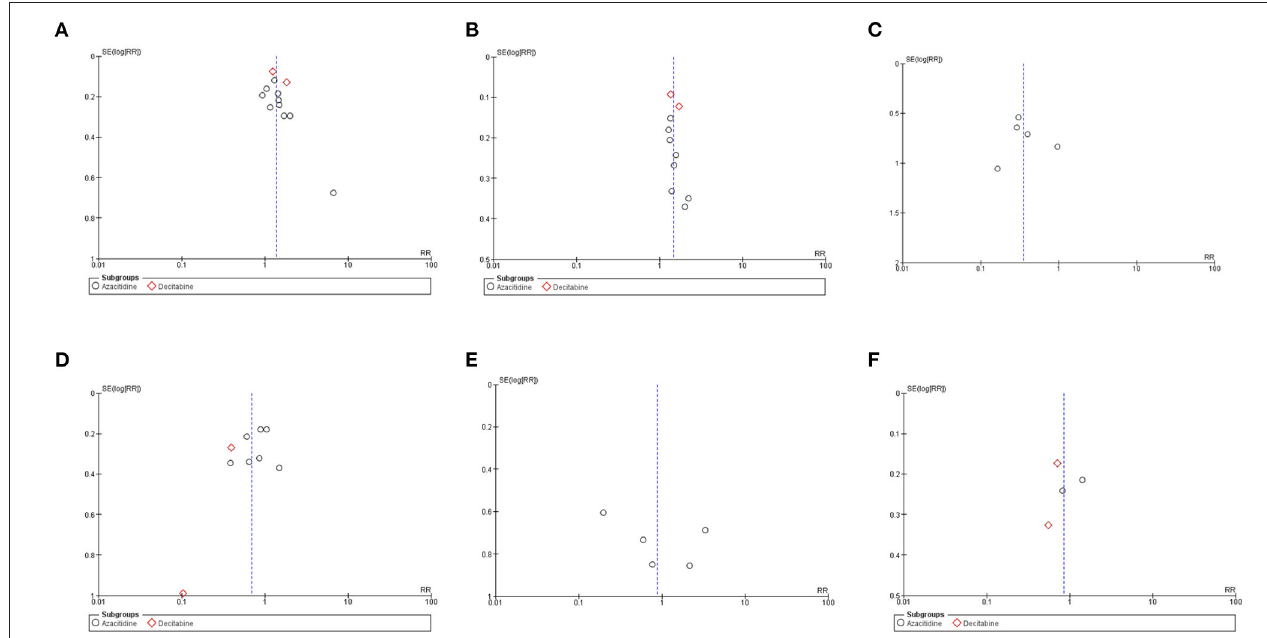
FIGURE 5 | Funnel plots of the meta-analysis of HMA maintenance compared with no HMA maintenance. (A) OS rate. (B) RFS rate. (C) NRM rate. (D) CIR rate. (E) grade III–IV aGVHD rate. (F) cGVHD rate.